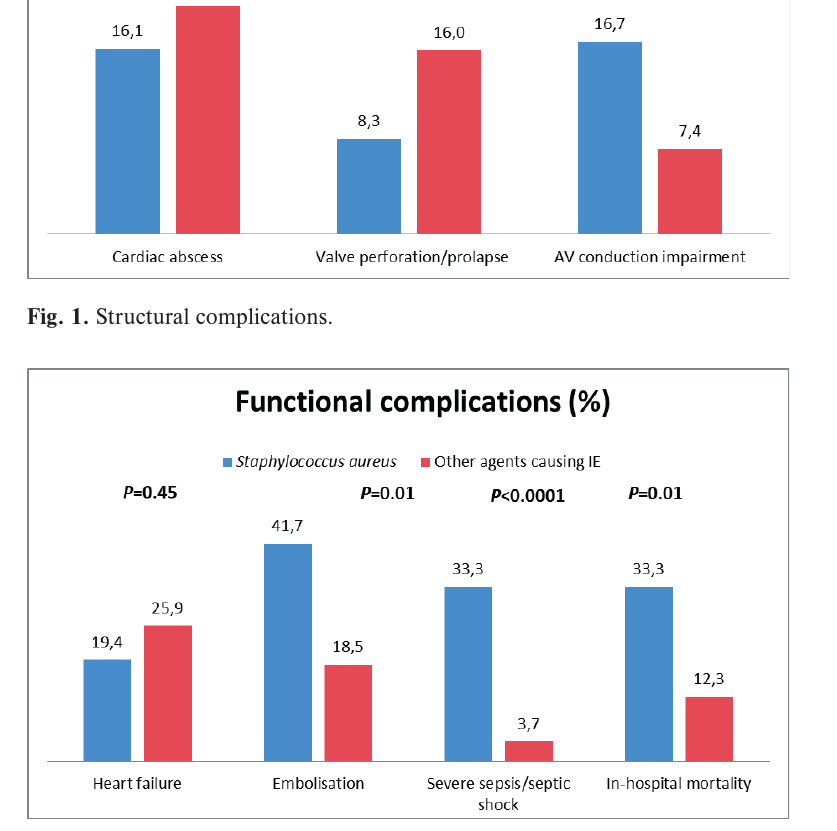
Fig. 2. Functional complications.